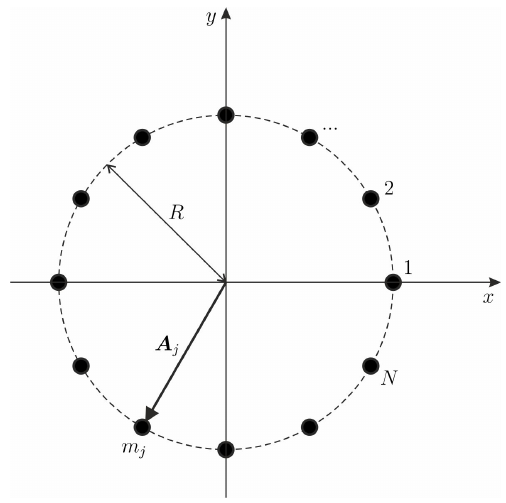
Figure 2. Finite cluster of N masses m j , attached to an elastic plate and located along a circle of radius R . The total mass is given by M